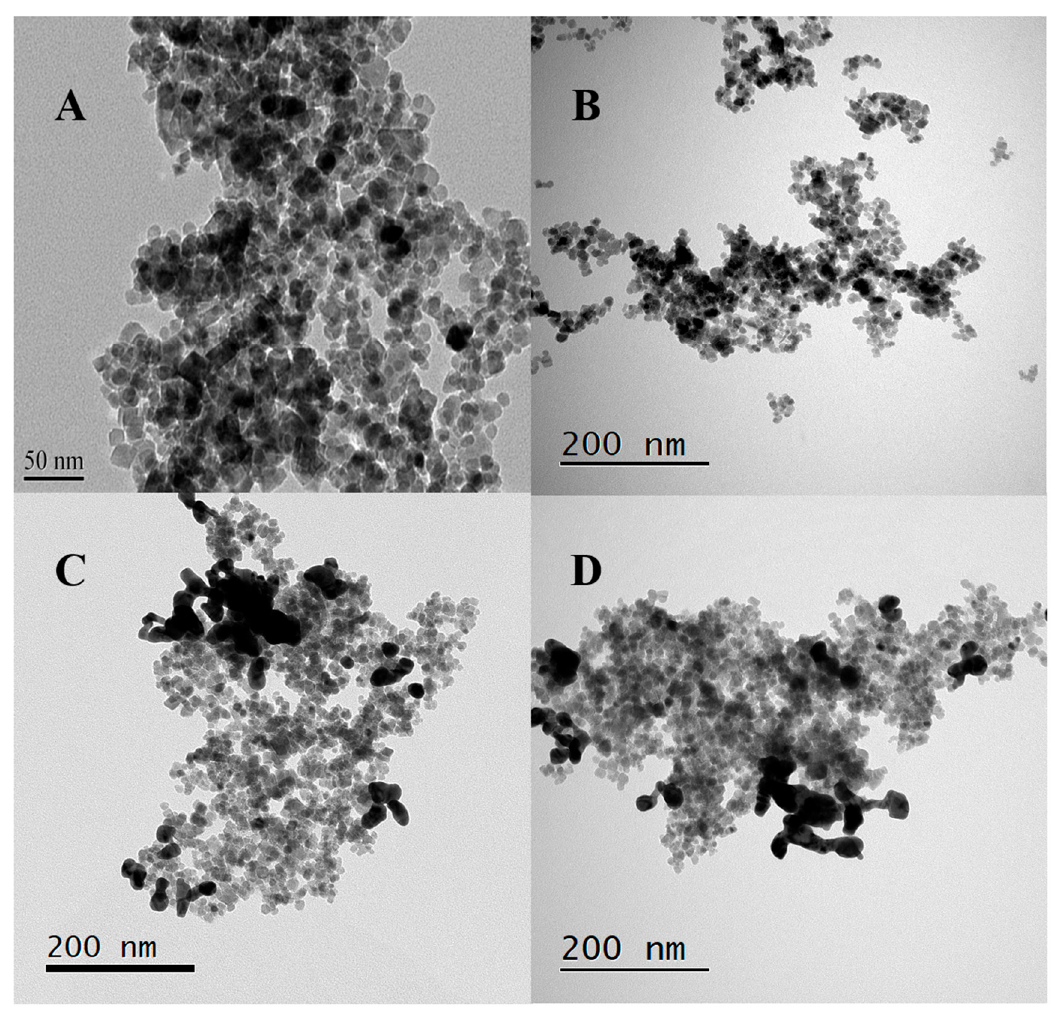
Figure 2. TEM images. ( A ) Commercial iron oxide nanoparticles (image from www.usnano.com). ( B ) Synthetic iron oxide nanoparticles. ( C ) Gold coated commercial iron oxide nanoparticles ( D ). Gold coated synthetic iron oxide nanoparticles. (See the supporting information in Figure S1A–C for more TEM images).